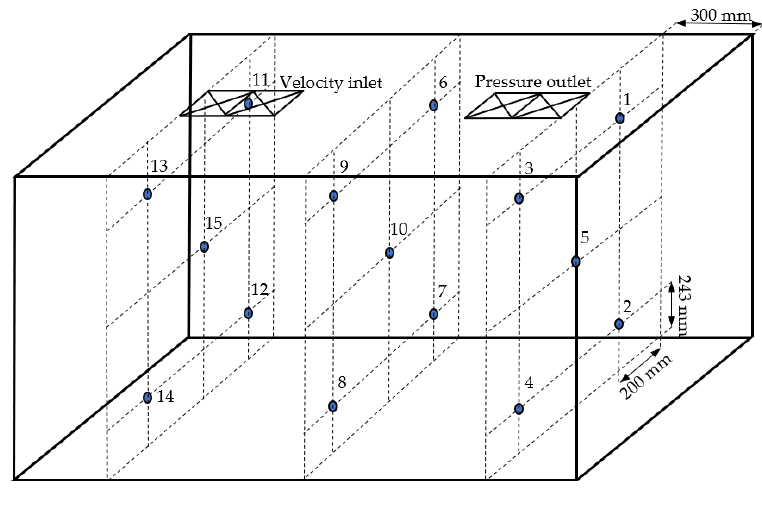
Figure 3. Schematic of measuring points.